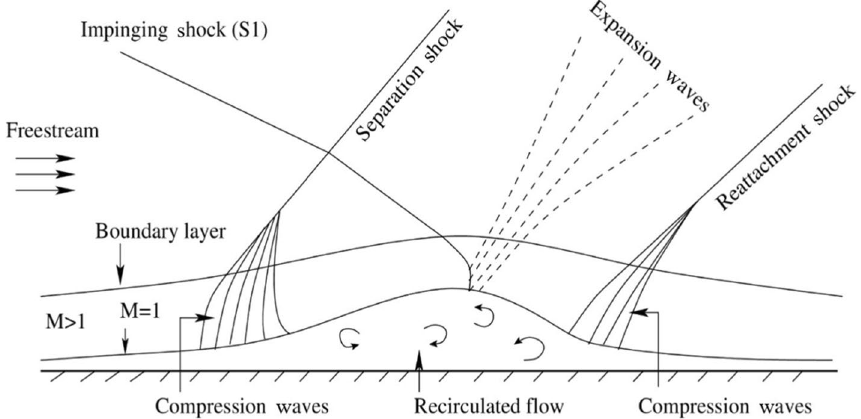
Fig. 3 Schematic diagram of a typical SBLI over a flat surface due to a strong impinging